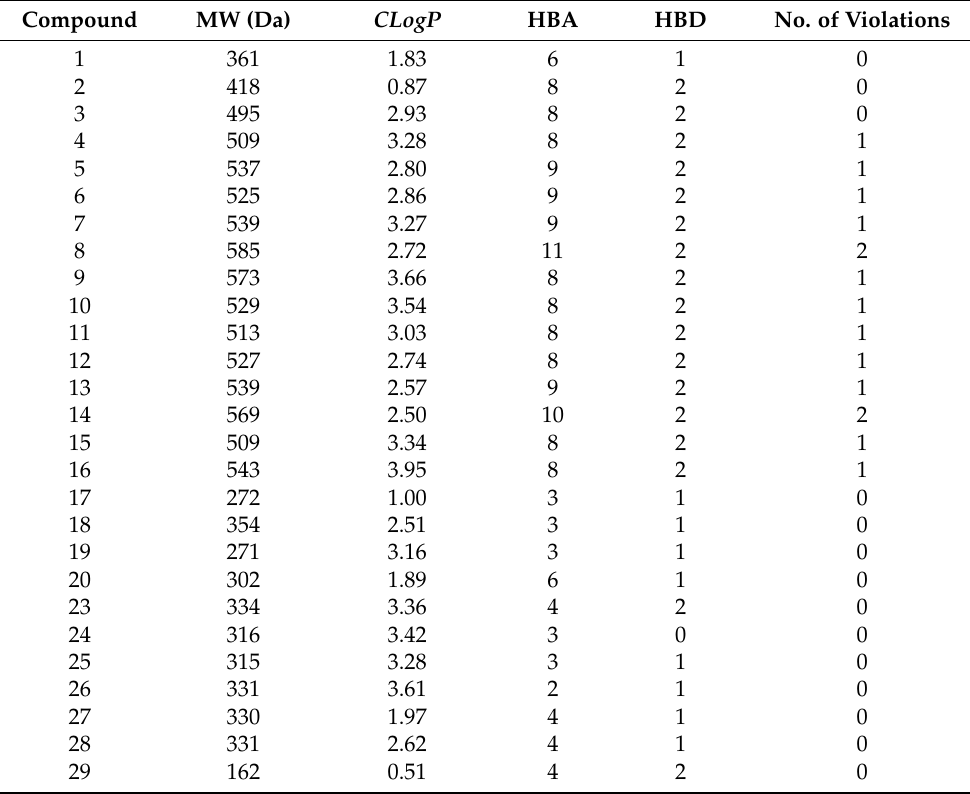
Table 3. Summary of the physicochemical properties of compounds 1–20 and 23-29 .